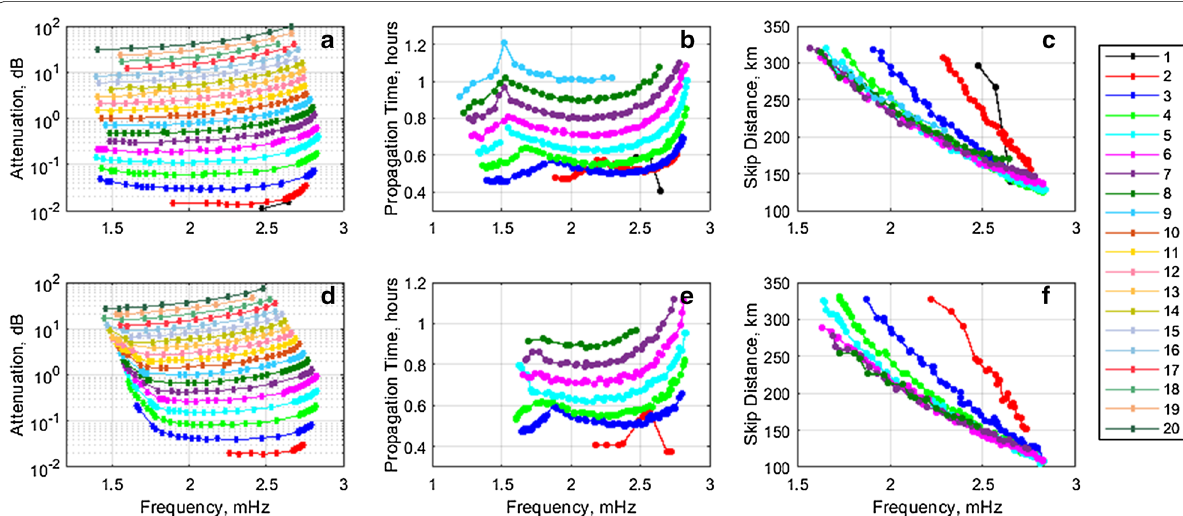
Fig. 7 Properties of buoyancy resonances in a mid-latitude atmosphere. AGW attenuation, travel time, and distance between consecutive returns to the ground level (skip distance) are calculated asymptotically in the ray approximation (Georges 1972; Gossard and Hooke 1975; Godin 2015) for a discrete subset of resonance frequencies under the atmospheric conditions at Wallops Island, Virginia, at GMT 06:00 ( a – c ) and GMT 18:00 ( d – e ) on 15 January 2014. The background atmospheric temperature and wind velocity profiles used in the simulations are obtained with the NRLMSISE-00.2 (Picone et al. 2002) and HWM14 (Drob et al. 2015) models, respectively. Different orders n of the resonances are distinguished by color of symbols and indicated in the figures. a , d Wave attenuation due to air viscosity and thermal conductivity (Godin 2014) on the path from the ground level to the turning point is shown in dB for resonances with n 20. b , e AGW propagation time from the ground level to the turning point is shown for the ≤ well-defined resonances with the attenuation not exceeding 1 dB. c , e Same as in b , e but for the skip distance of AGW rays corresponding to the